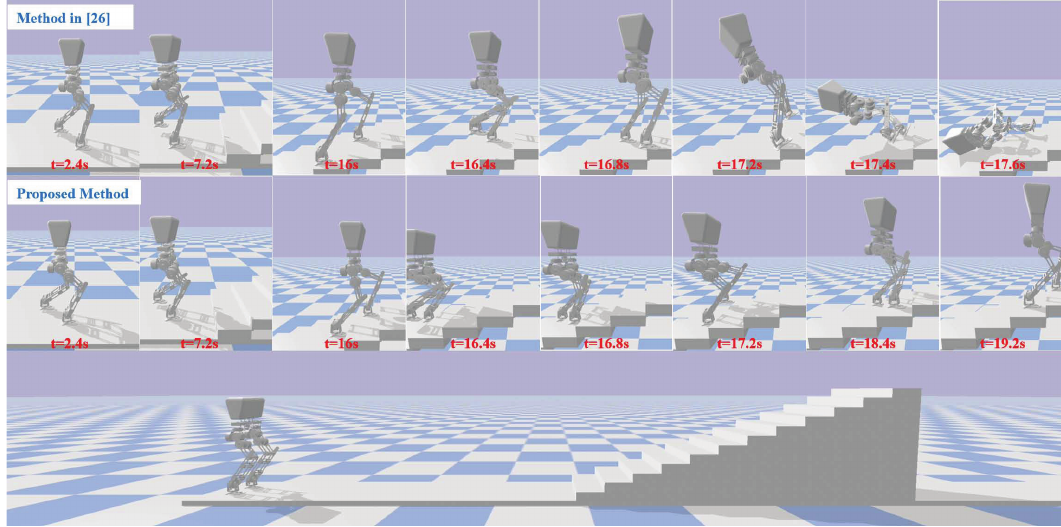
Figure 9. Snapshots of climbing stairs (Simulation platform: